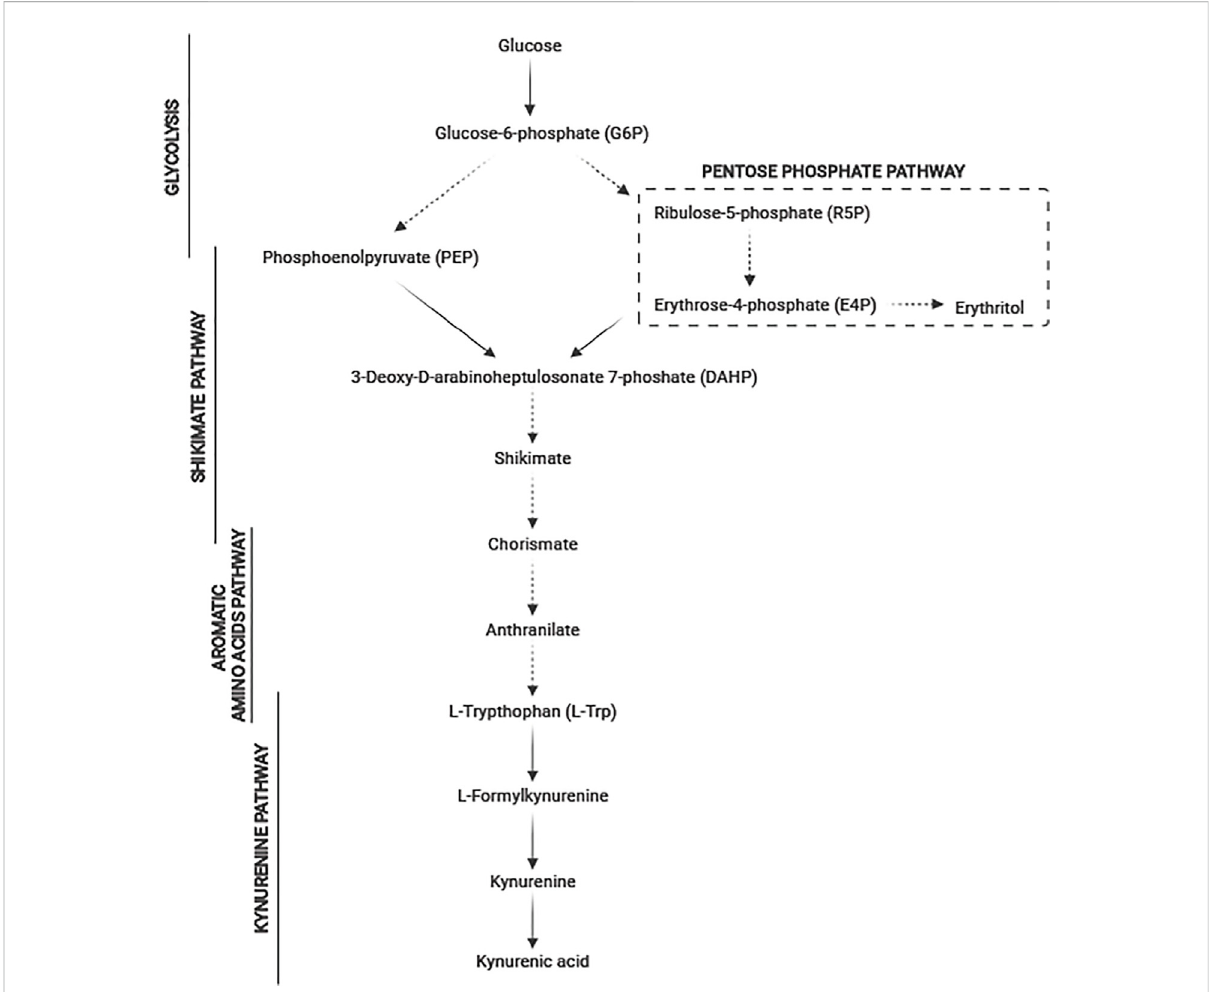
FIGURE 1 Metabolic pathway of tryptophan degradation to kynurenic acid in yeast (dashed line means multistage conversions; solid line means single- stage reactions).